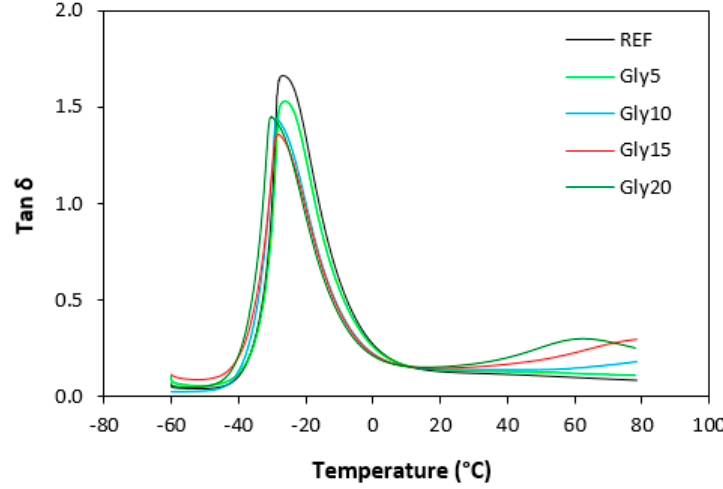
Figure 19. Temperature dependences of tan δ for vulcanizates based on SBR.